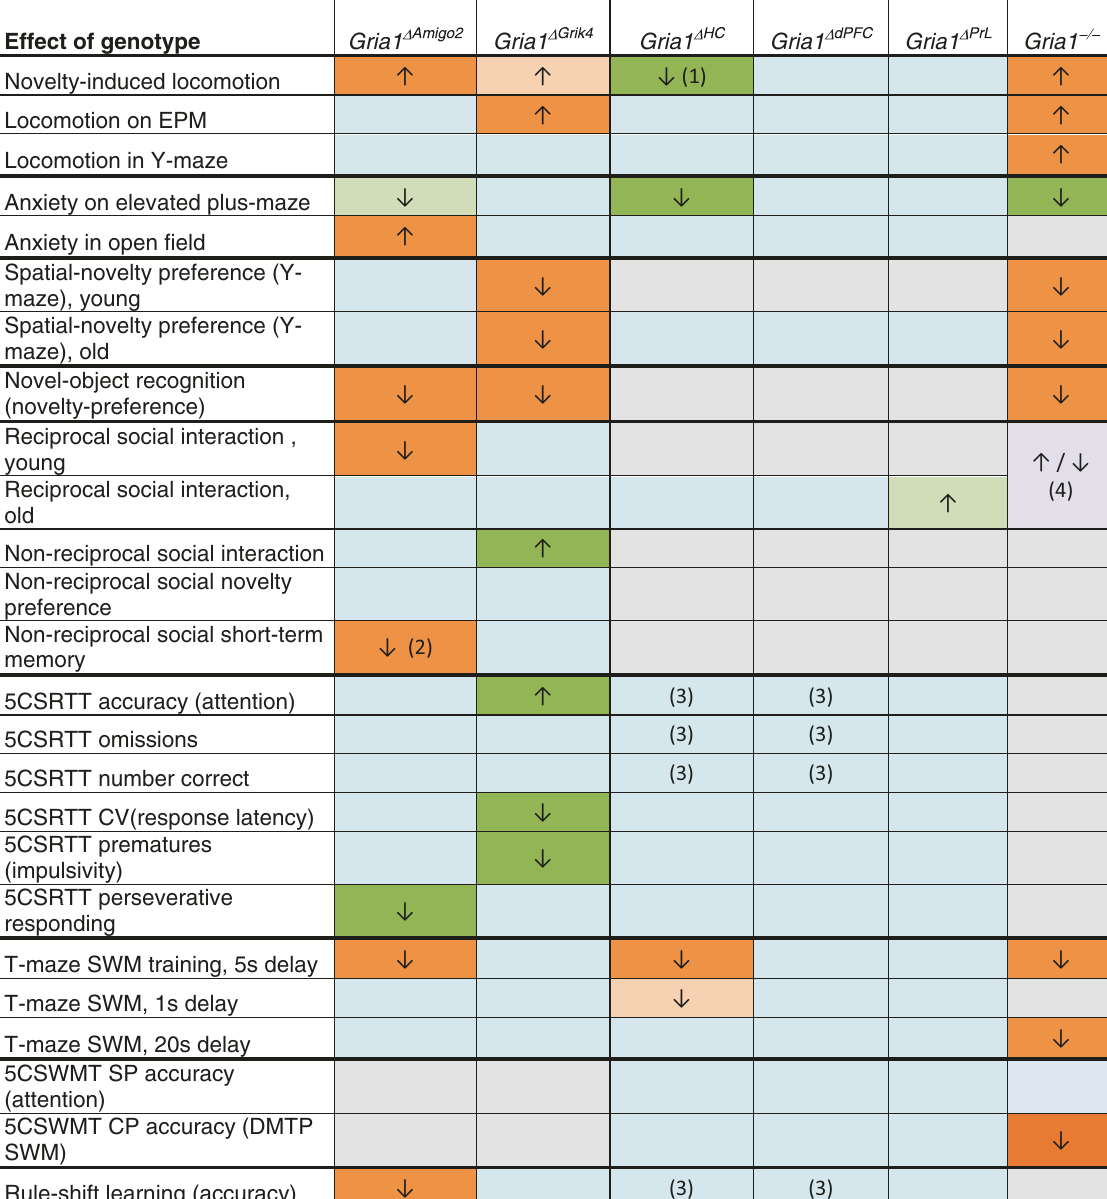
Table 1. Summary of behavioural results in transgenic and AAV cohorts.